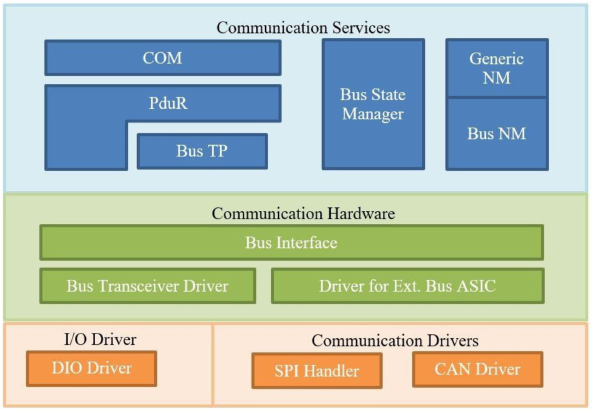
Figure 2. Bus Communication